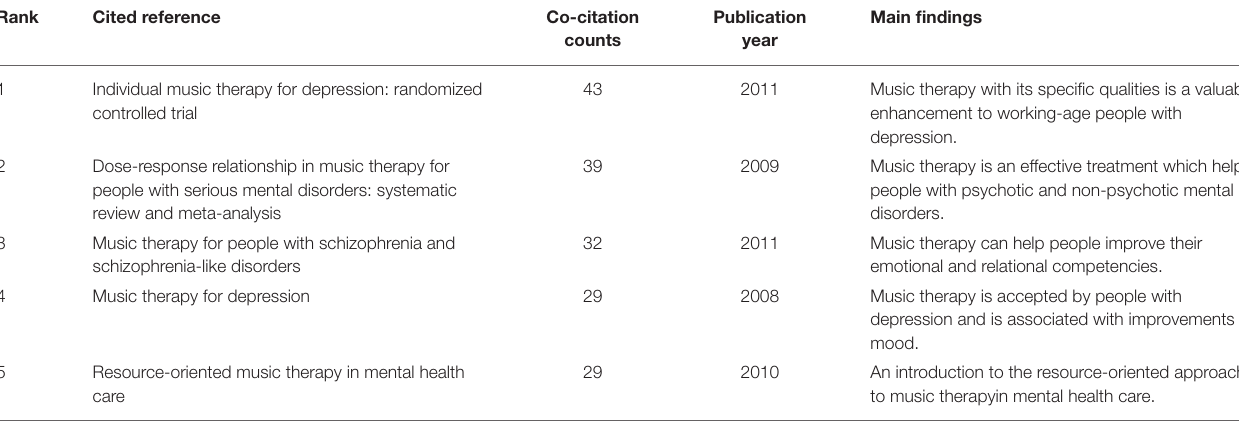
TABLE 6 | Top five co-cited references with co-citation counts in the study of music therapy from 2000 to 2019.